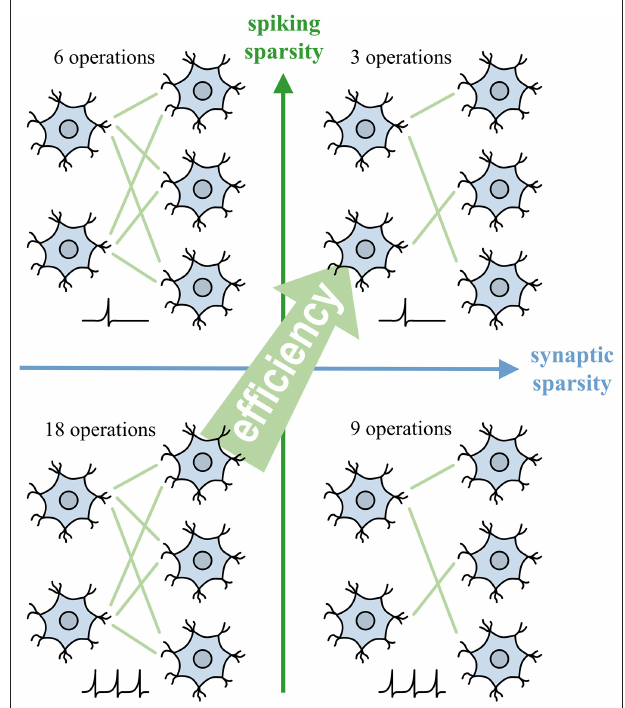
FIGURE 1 | Spiking sparsity and synaptic sparsity facilitate the efficiency of SNN by reducing the number of synaptic